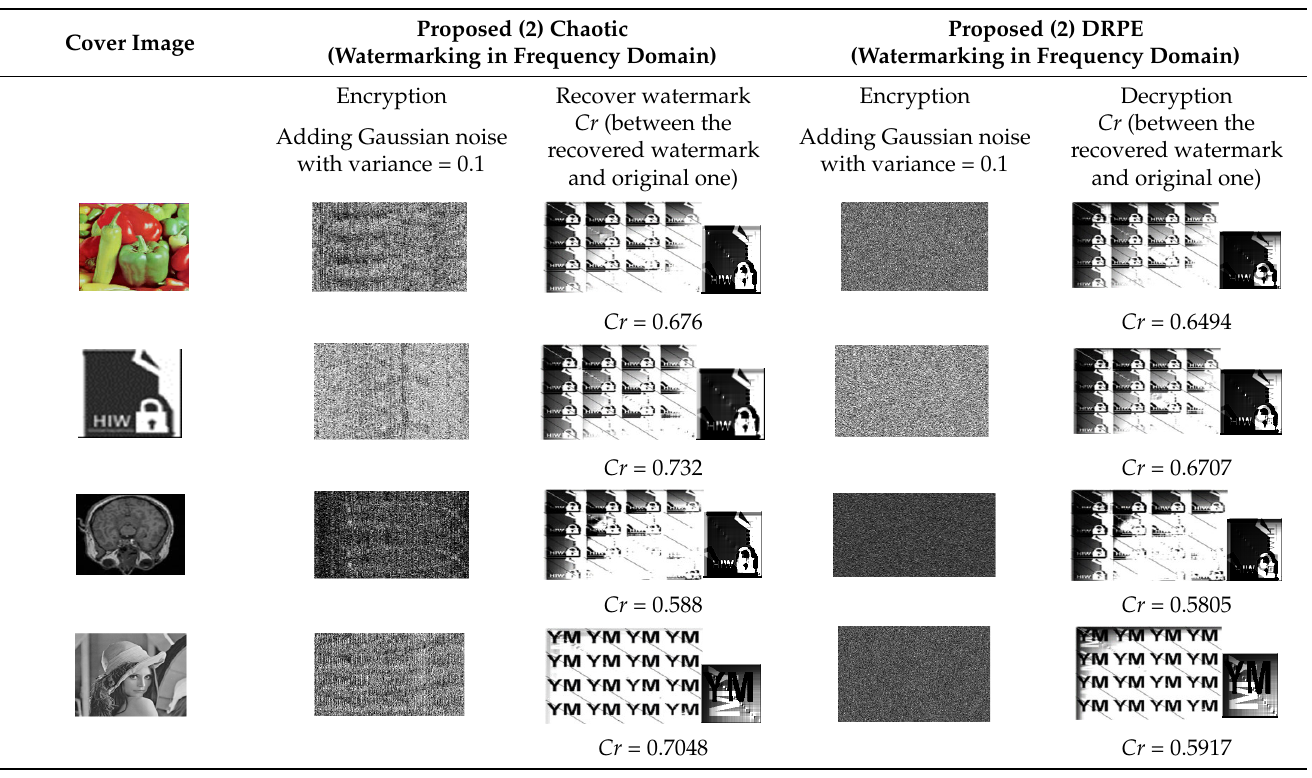
Table 16. Gaussian noise images and corresponding extracted watermarks for the second proposed technique 2.